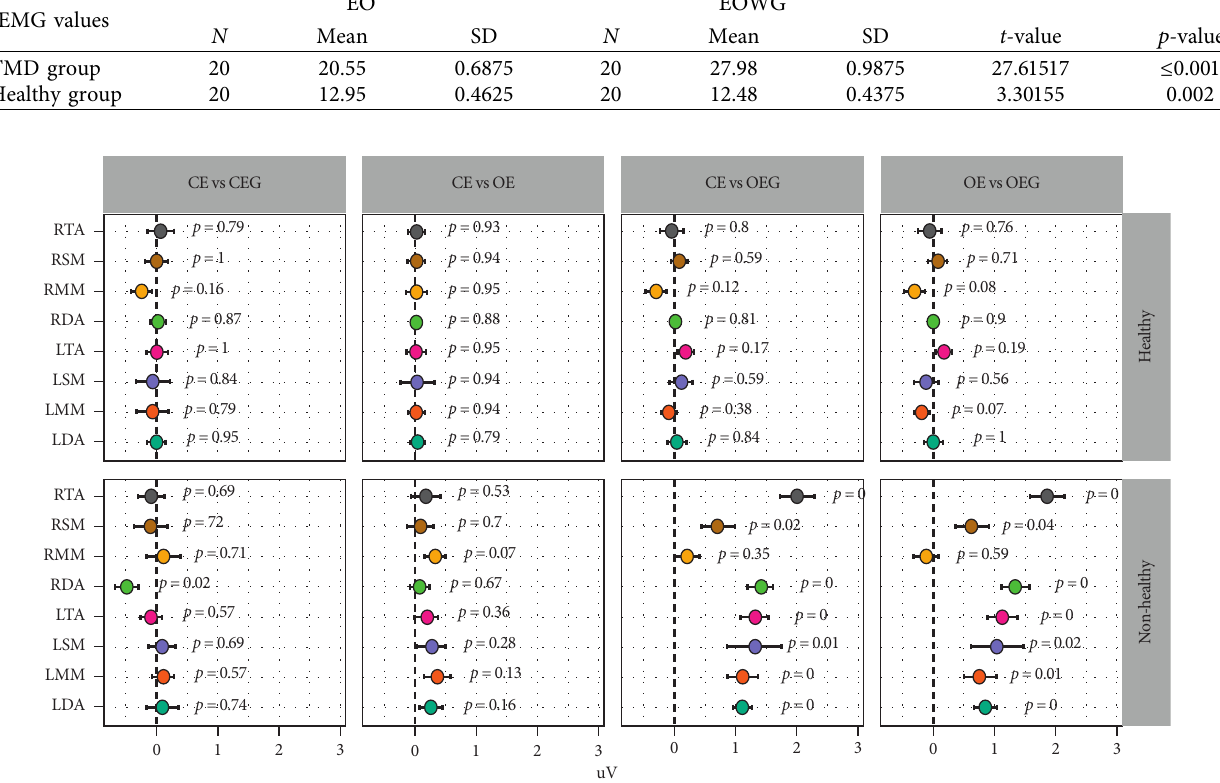
Figure 2: Results of electromyographic values in the two